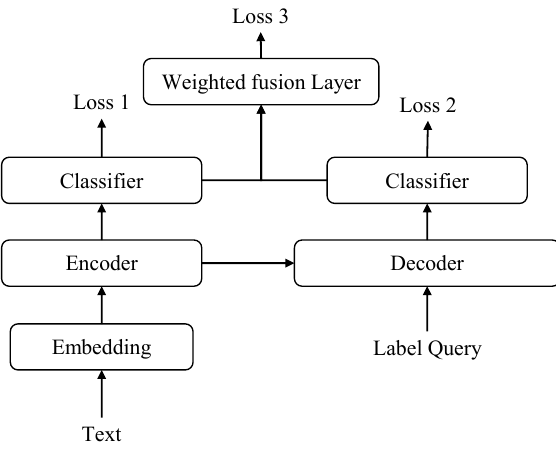
Figure 1. The overall framework of the JE-FTT model.